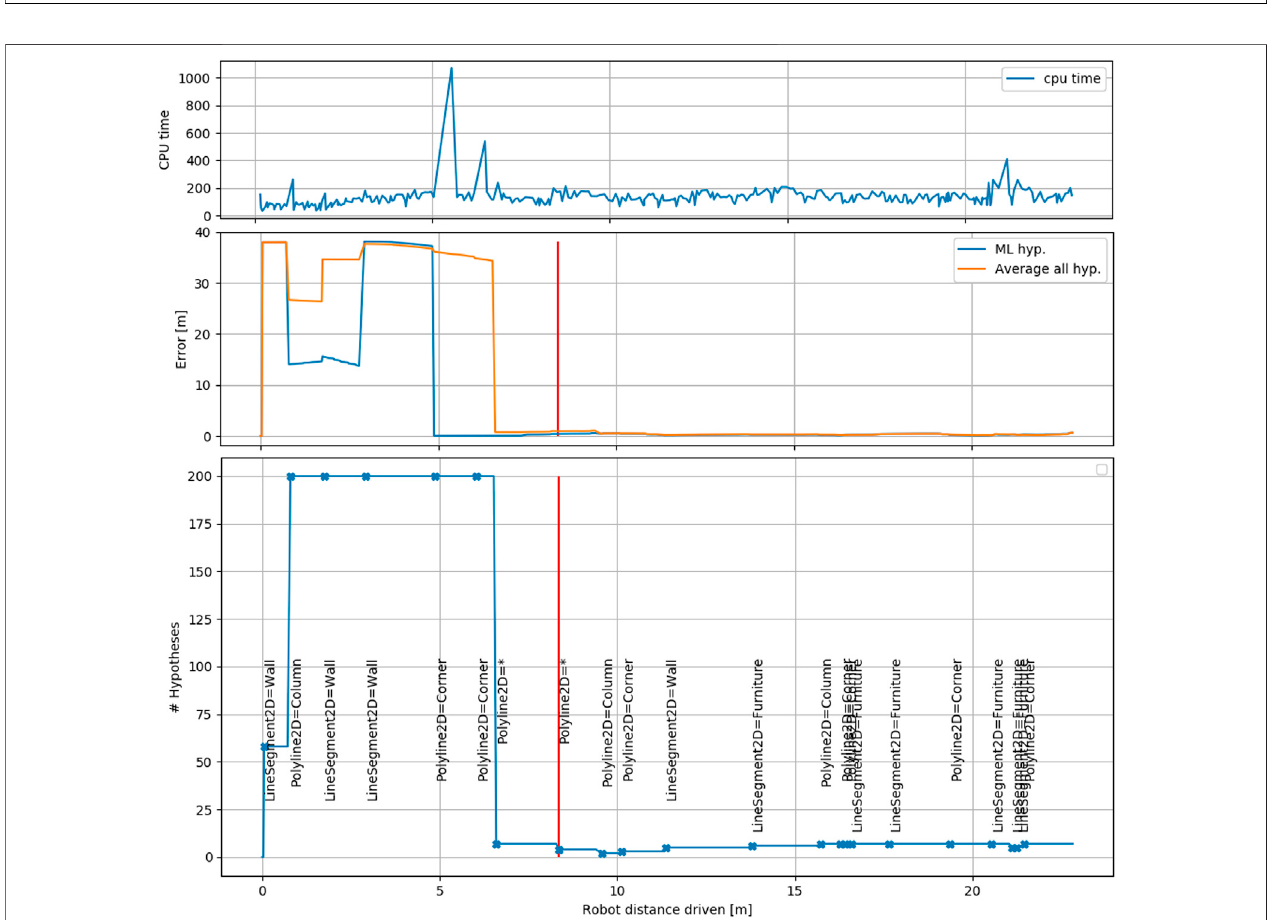
FIGURE 12 | The CPU time, error and hypotheses shown for B3. The middle fi gure shows the error for both the maximum-likelihood hypotheses and the average over all hypotheses that permit a pose registration. The moment where our approach marks itself as localized is shown in red. Below, the number of hypotheses is shown, together with events that indicate that a new association is evaluated. The association for the ML hypothesis is shown in text (* indicates unmapped object). The top fi gureshowsCPUcycletime(milliseconds)forsessionB3.Withinacycle,thelocalmapisalwaysupdatedandtheassociationsareonlyupdatedifanewstable local feature is available. The latter causes the distinct peaks in processing